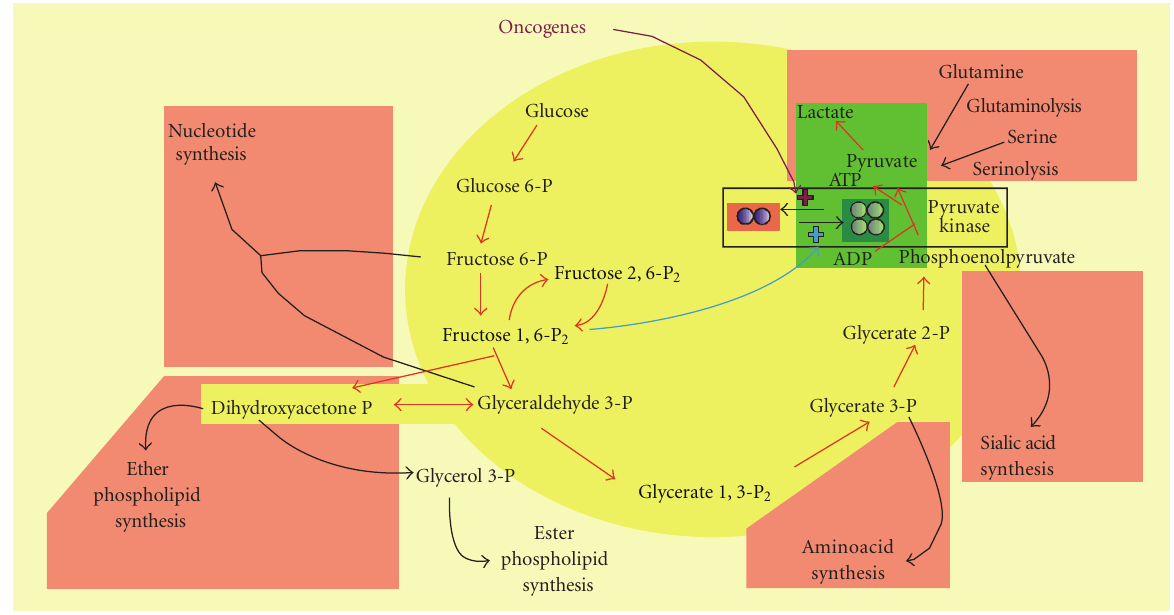
Figure 4: Tetrameric M2 pyruvate kinase-driven fuel-generating (green panel) and dimeric M2 pyruvate kinase-driven biosynthetic precur- sor-generating (red panels) glycolysis (yellow panel) in cancer cells. Tumoral M2 pyruvate kinase exists in a dimeric inactive form that blocks pyruvate and ATP formation from glucose. It induces the accumulation of energy-rich phosphometabolites found upstream in the glycolytic pathway and o ff which biosynthetic processes may branch. Interconversion to the active tetrameric form of the enzyme may occur when the glucose supply is high, leading to a rise in fructose 1,6 bisphosphate which stimulates this tetrameric conversion. When glucose levels are high, cancer cells may then produce energy at the same time as supplying biosynthetic pathways. In this situation, the rise in glycolytic inter- mediary rich energy phosphometabolites results not from a block located downstream of their production but from an increased load of glycolysis by glucose. When glucose levels fall again, the subsequent decrease in fructose 1,6 bisphosphate results in recruitment of the dimeric inactive form of M2 pyruvate kinase. In this case, both energy and pyruvate production (and hence formation of lactate) by the tumor may derive from the catabolism of aminoacids such as glutamine and serine. The latter sets of metabolic reactions, by analogy with glycolysis for glucose to lactate production, are referred to as glutaminolysis and serinolysis, respectively. The supply of these aminoacids to the tumor is associated at distance with notably muscle proteolysis, explaining the progression of patients towards a cachectic state when the tumor gains in growth and development. Cachexy may be also favored by energy wasting associated to uncoupling of mitochondria in some cancer cell lines. Except with tumors such as insulinoma and hepatoma, for instance, no hypoglycaemia is, however, induced in patients since a sustained production of lactate is ensured by the tumor from these aminioacids. Lactate may be recycled to glucose by gluconeoformator cells, mainly hepatocytes (Cori’s cycle). Biosynthetic pathways branching o ff glycolysis include sialic acid, nucleic acid, aminoacid, ether glycerolipid, and ester glycerolipid anabolic pathways. The latter pathway is not emphasized here by inclusion in a red panel because in many cancer cell lines glycerol phosphate dehydrogenase is deficient thus reducing the availability of glycerol 3-phosphate and limiting incorporation of neoformed fatty acids into lipids. Fatty acid synthase is often overexpressed, and, along with the removal of fatty acids (known for immunosuppressive properties) outside the cell, it allows tumoral cells to cope with the massive rise in glycolysis- driven NADH and proton (H + ) formation (glyceraldehyde 3-phosphate dehydrogenase step), avoiding excess acidification and consequent cell death. The threshold for reversible interconversion of tetrameric to dimeric M2 pyruvate kinase may be lowered by oncogenes in favor of the dimeric form. As mentioned in the text, the tetrameric active form is part of the glycolytic complex (a complex which groups most glycolytic enzymes for optimal metabolic function and energy production) whereas the dimeric form separates from this glycolytic